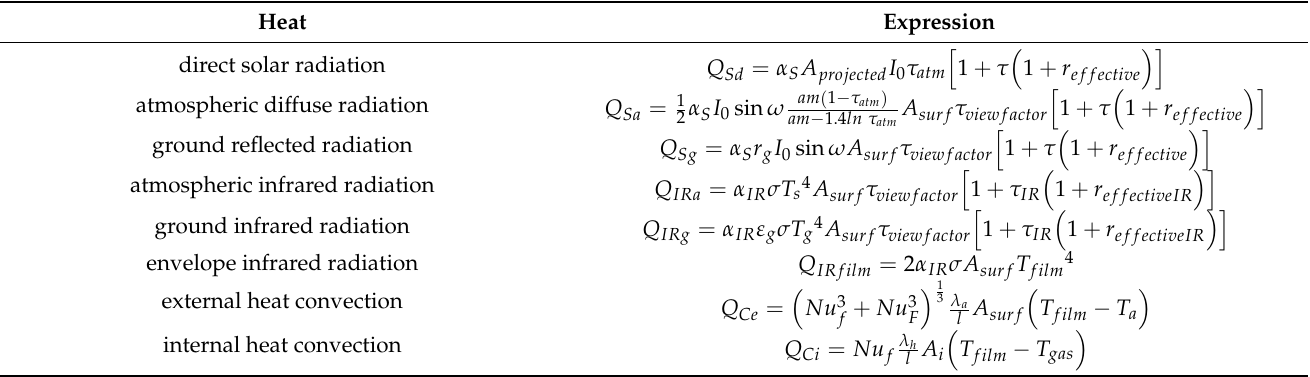
Table 1. Expressions for solar radiation, infrared radiation and thermal